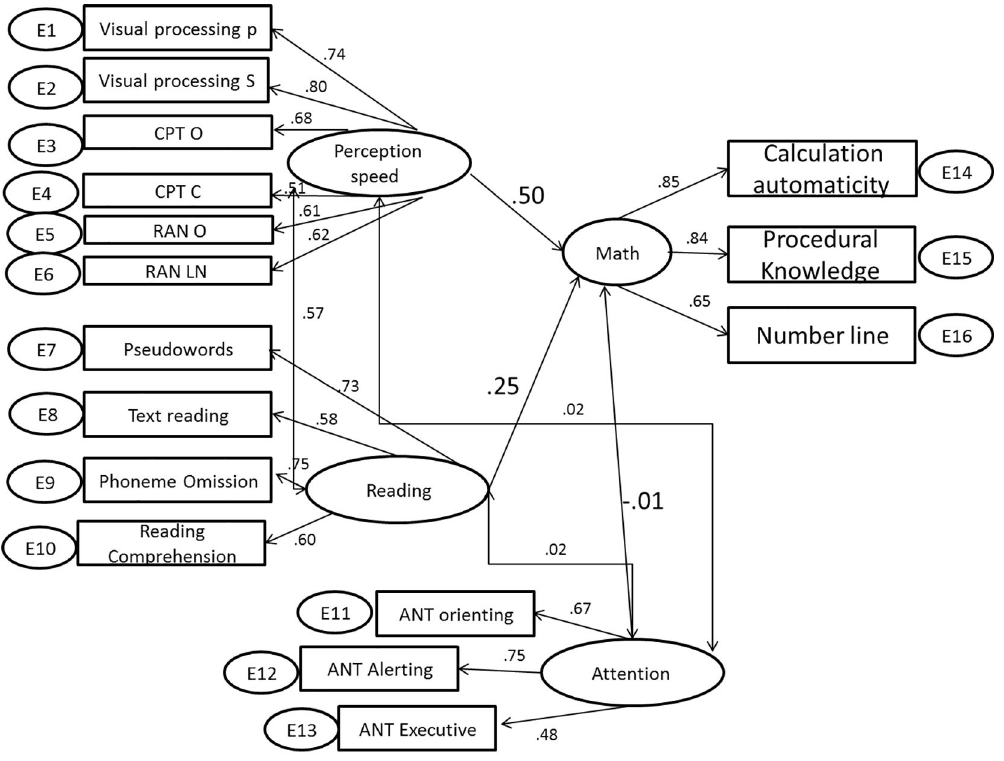
Figure 3. Final model based on the factor analysis including 2 latent variables: perception speed and reading predict mathematics abilities. Attention (ANT) did not have direct role in explaining mathematics abilities in the current model. Visual processing P = visual processing parallel; CPT O = continuous performance task omission; CPT C = continuous performance task commission; RAN LN = rapid automatized naming letter/number; ANT orienting = attention network test orientation; ANT Alerting = attention network test alertness; ANT executive = attention network test